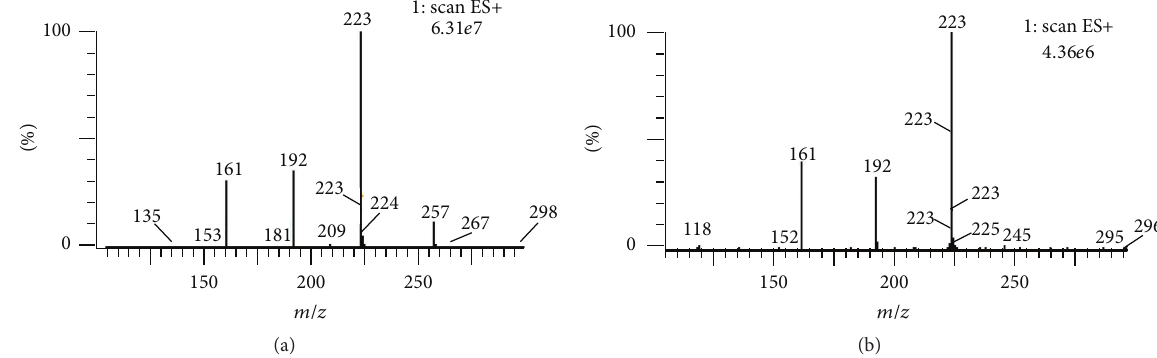
Figure 2: MS/MS spectra of (a) peak 5 in TIC chromatogram of WJSH capsule serum sample; (b) standard of